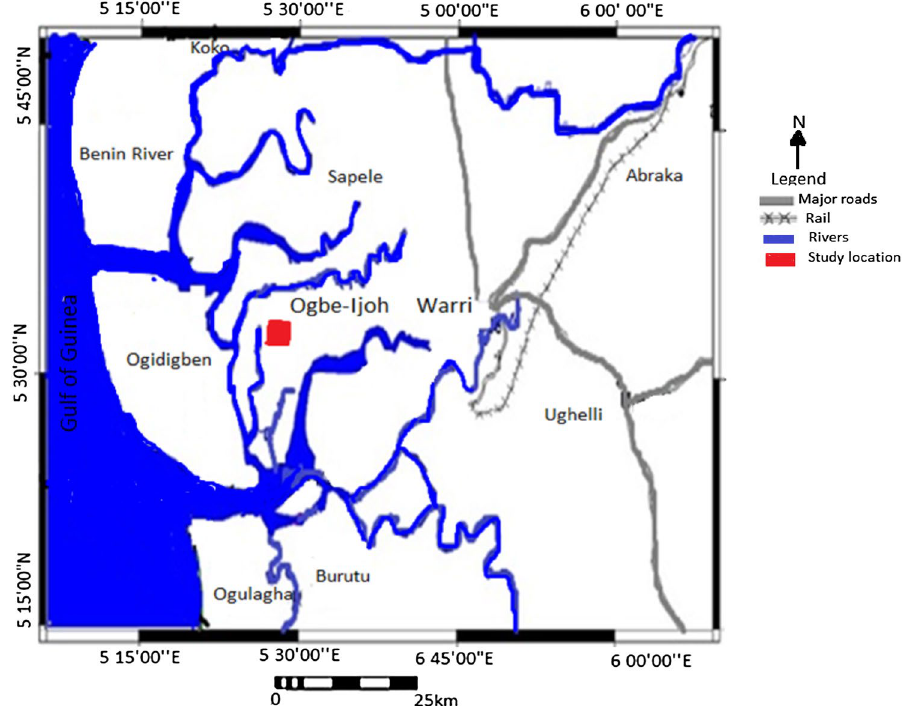
Fig. 1 Map showing the study